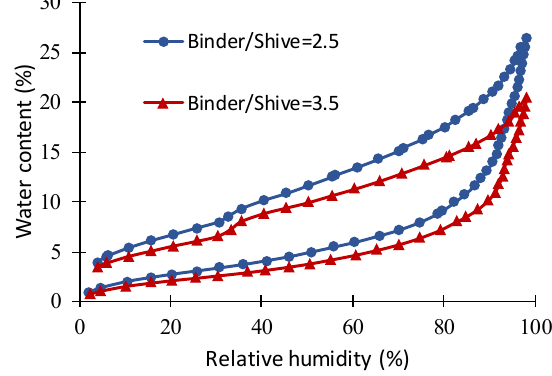
Figure 3. Adsorption and desorption isotherm curves of hemp